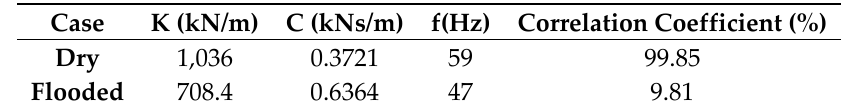
Table 1. Ballast